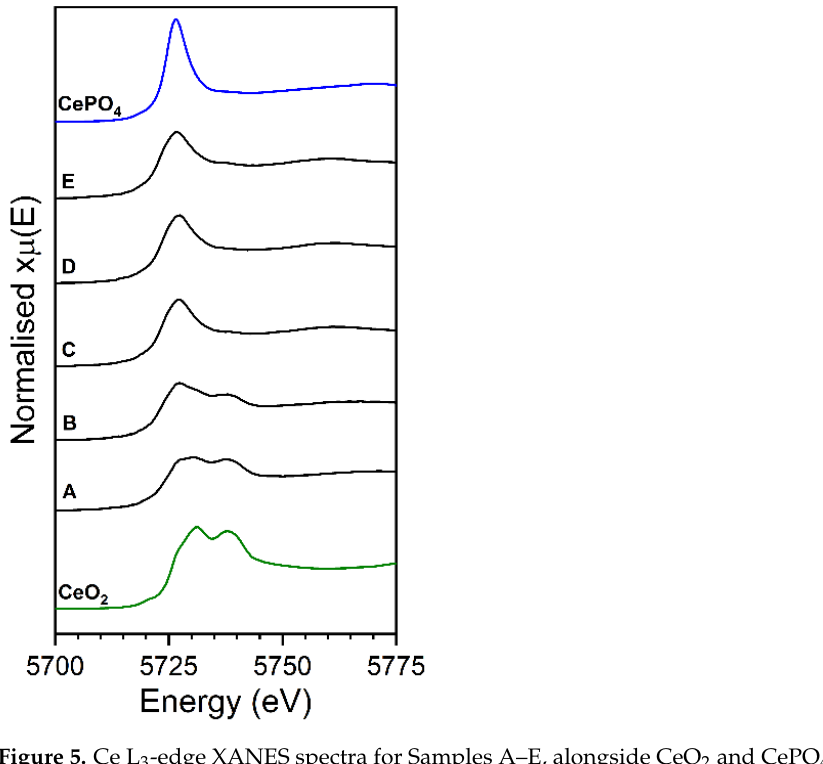
Figure 5. Ce L 3 -edge XANES spectra for Samples A–E, alongside CeO 2 and CePO 4 reference com- pounds. Table 6. Linear combination fitting of Ce L 3 -edge XANES data.